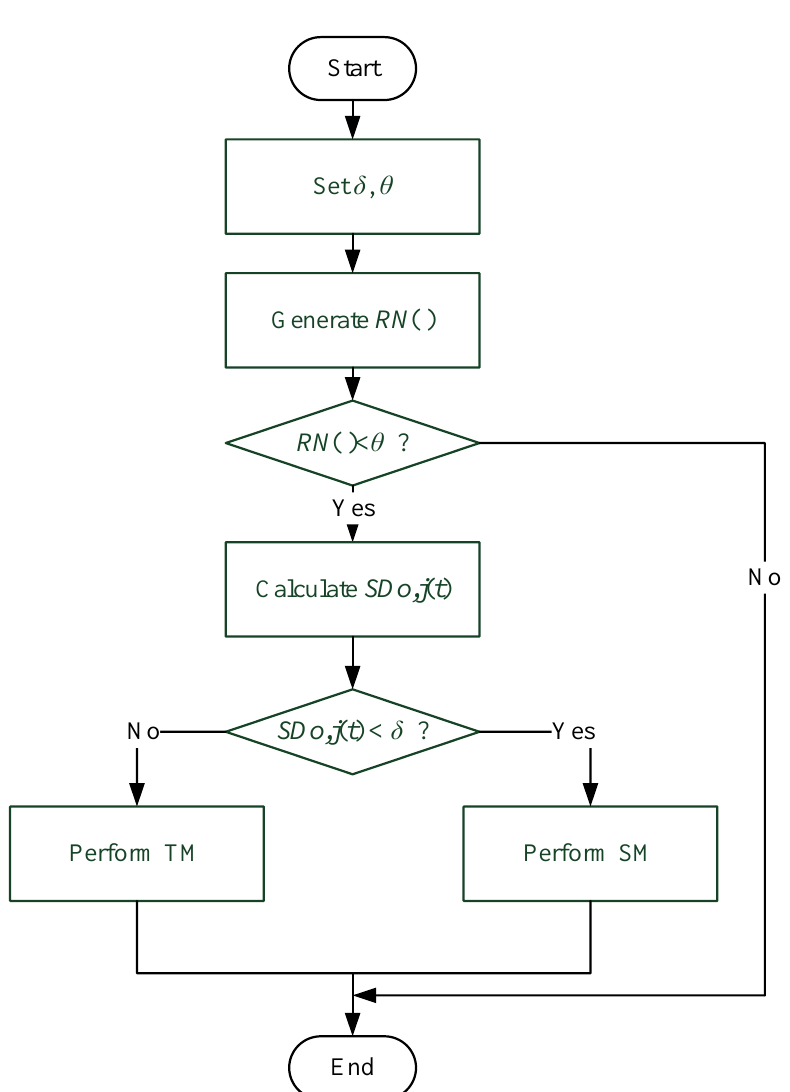
Figure 12. The algorithm of mutation in the multiple particle swarms optimization (MPSO).